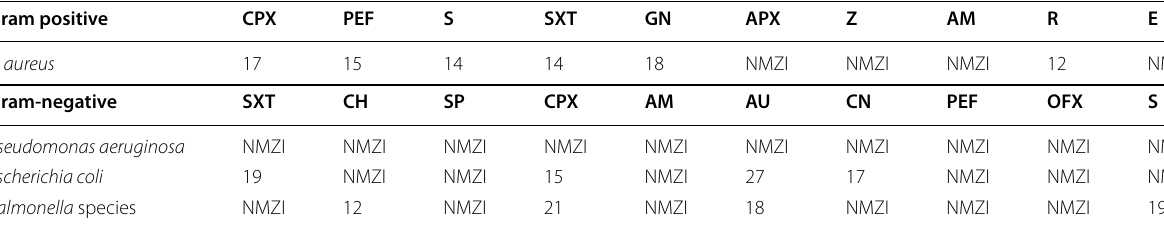
Table 8 Zone of inhibition (mm) for antibiotics susceptibility test Gram